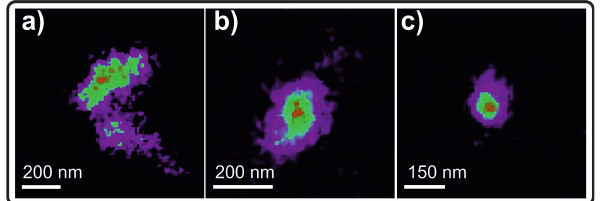
Fig. 4. STXM absorption images, measured at 320eV, of aged soot particles emitted from (a) the Attika wood stove with an equivalent projected area diameter of around 500nm, (b) the EURO 2 trans- porter having a diameter of 260nm and (c) the EURO 3 passenger car with a diameter of about 170nm. The OD values scale up to